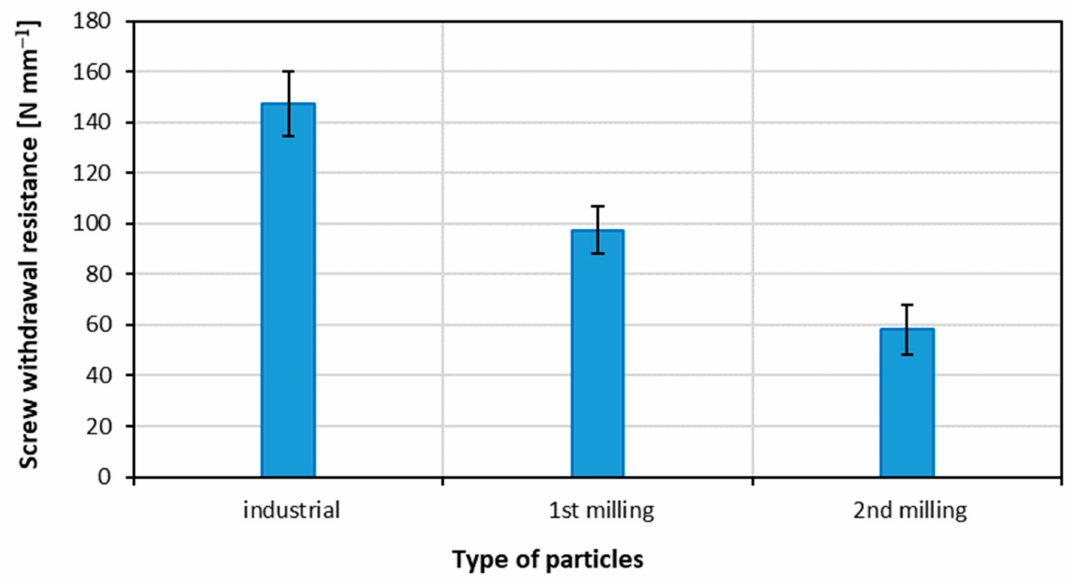
Figure 5. Screw withdrawal resistance of the panels produced using different